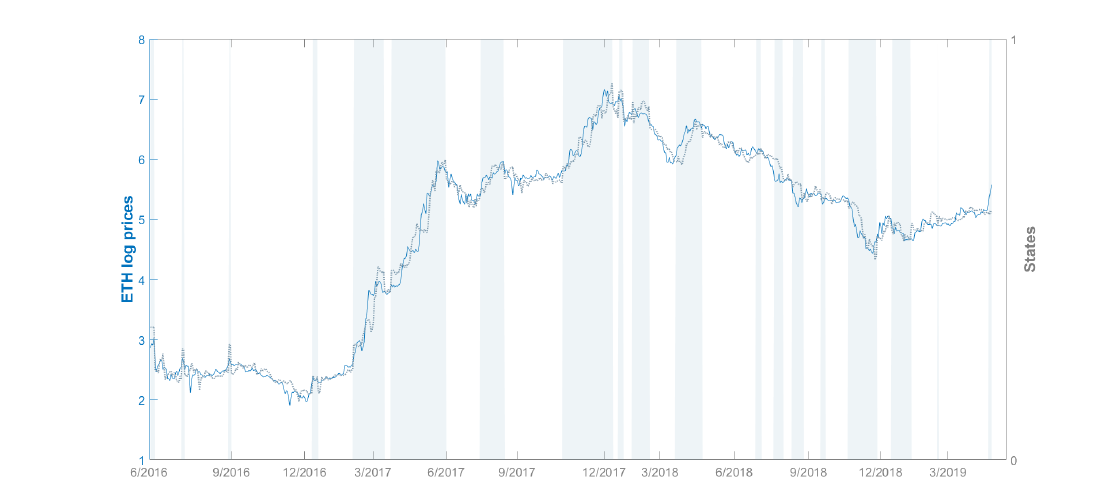
Figure 1. Logarithmic ETH price series (blue line) and in-sample estimated logarithmic ETH price series for the period 6/2016–5/2019 (gray dotted line). Shaded bars mark times with hidden state 1 (smoothed probability above 0.5). The model accounts for the heteroscedasticity of the series.